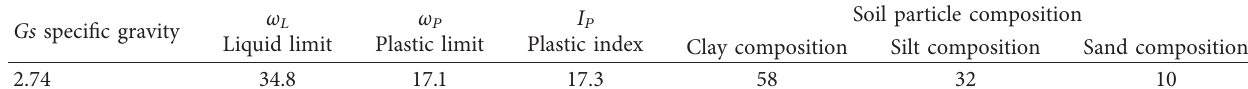
Table 1: Basic physical properties of